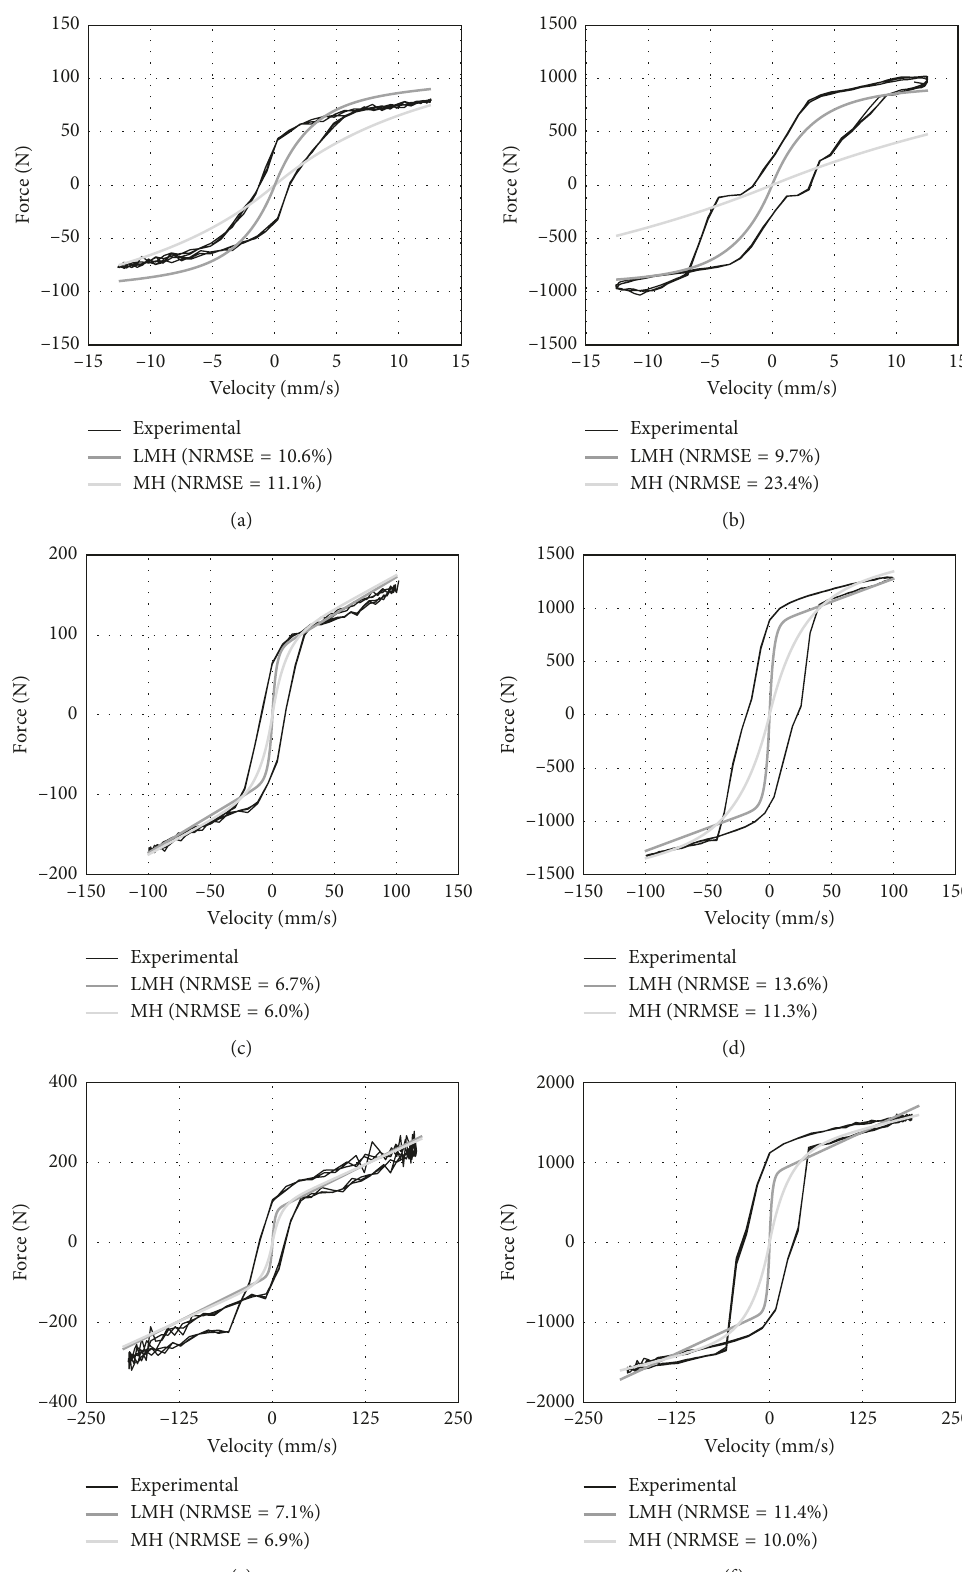
Figure 10: Regularised Bingham model (fitted with LMH and MH tests) predictions for six different tests: (a) low velocity without intensity; (b) low velocity with I 1A; (c) medium velocity without intensity; (d) medium velocity with I (cid:31) high velocity with I (cid:31)